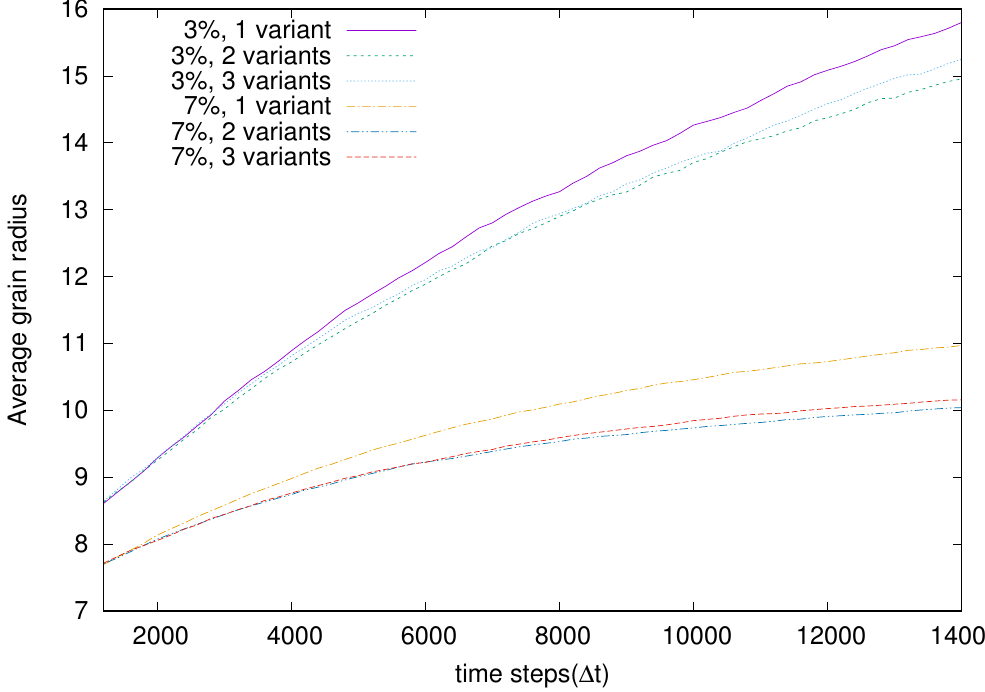
Figure 7. Average grain radius with respect to time when 3 vol% hydrides and 7 vol% hydrides are involved. We plotted the values for the cases of 1, 2 and 3 structural variants of the